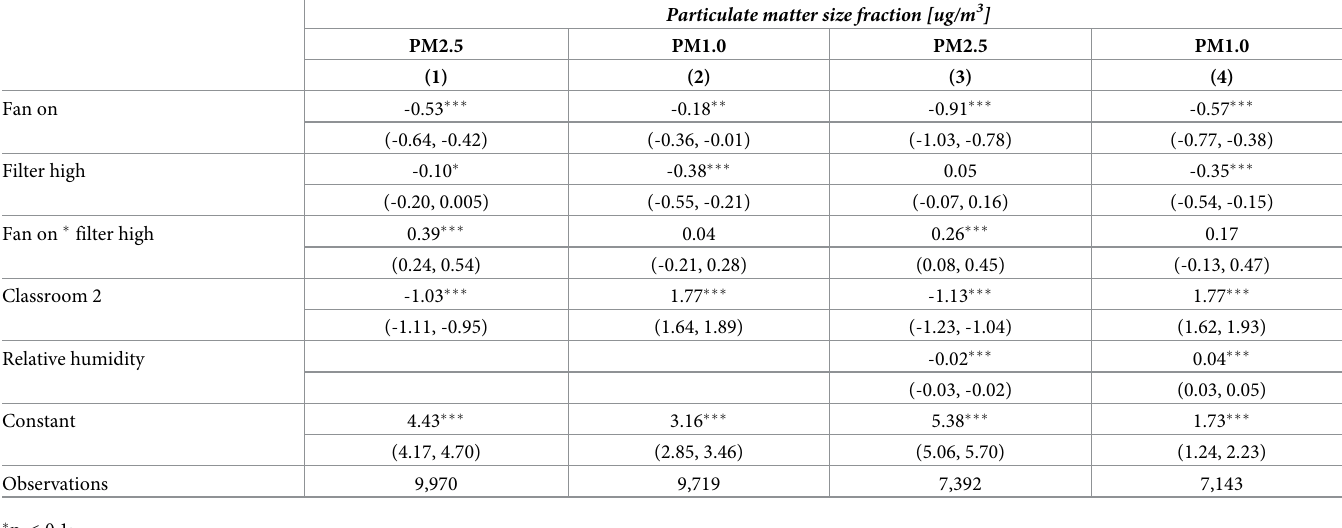
Table 3. Trial results from different scenarios of HEPA cleaner and air conditioning unit fan use in elementary school classrooms in Rhode Island,